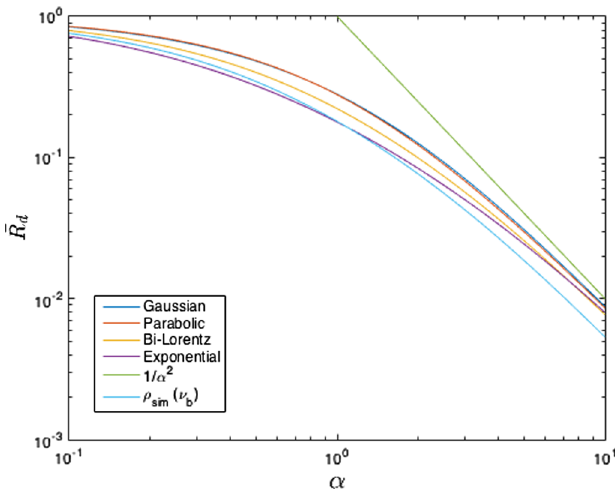
FIG. 9. Damper correction factor as a function of α for different values of σ ϕ